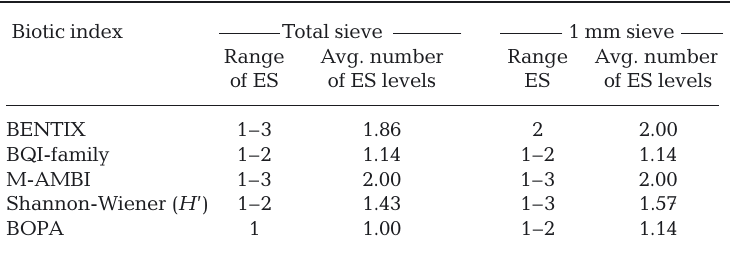
Table 3. Variability in ecological status (ES) at sampling stations calculated us- ing 5 biotic indices among replicate ‘total sieve’ and 1 mm sieve samples (N = 3 replicates at each